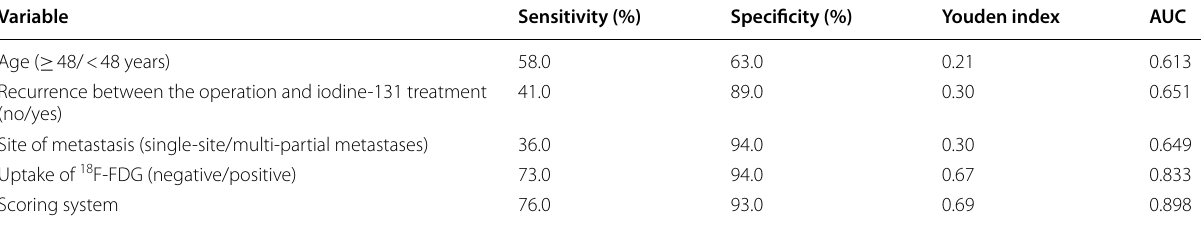
AUC, area under the curve; 18 F-FDG, 18 F-fluorodeoxyglucose